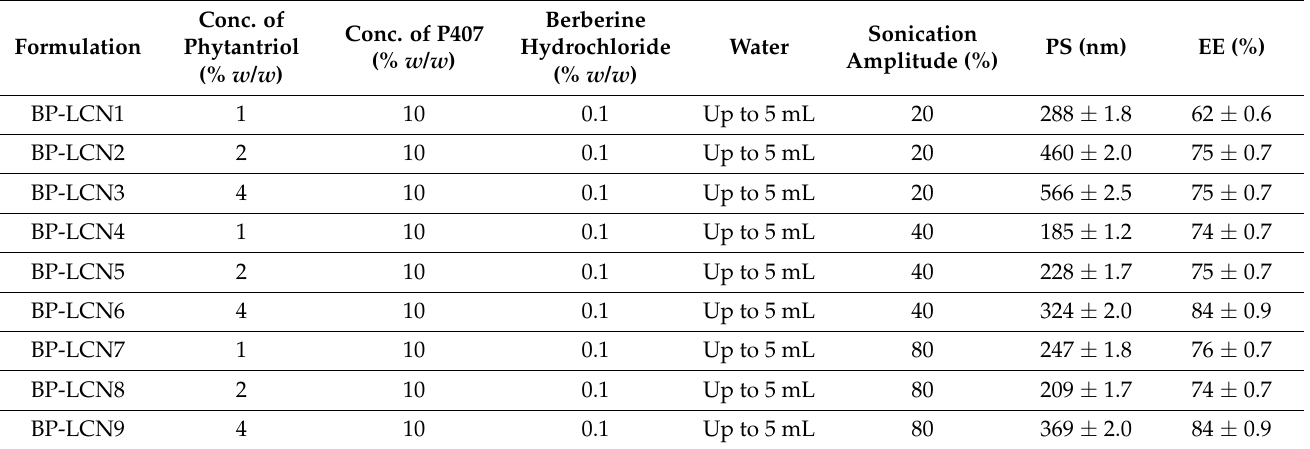
Table 1. Compositions of BP-LCN formulations and their characterization parameters. The PS and EE values are represented as means ± SD (n =